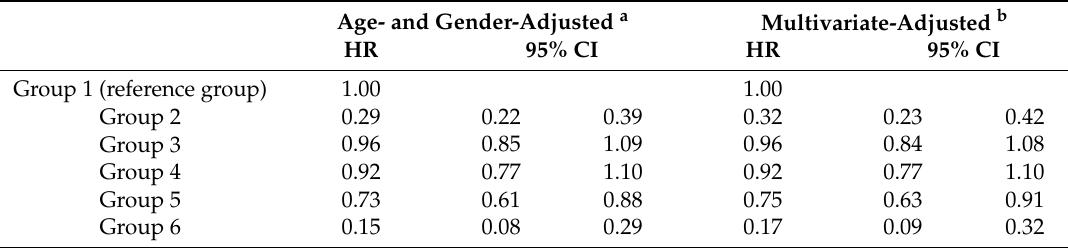
Table 3. Hazard ratios for hypertension according to MDA and changes in MDA. Age- and Gender-Adjusted a Multivariate-Adjusted b HR 95% CI HR 95% CI Group 1 (reference group)